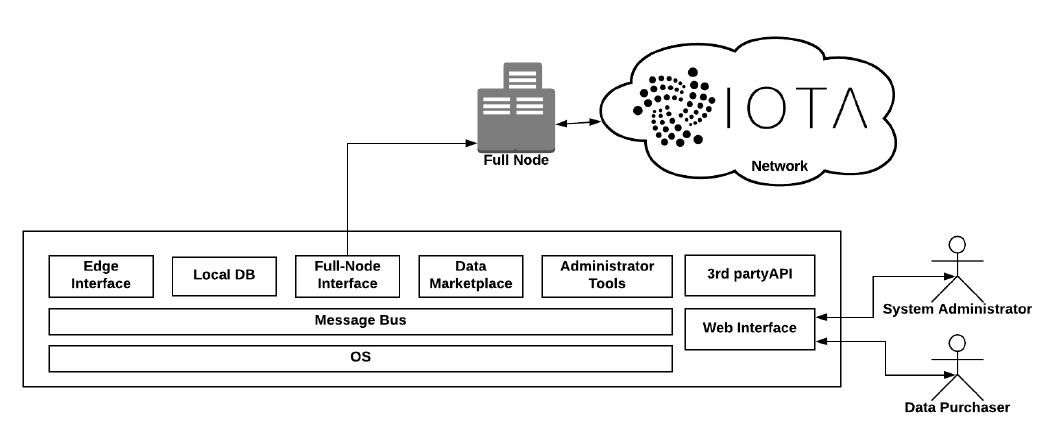
Figure 11. The Edge Super Node